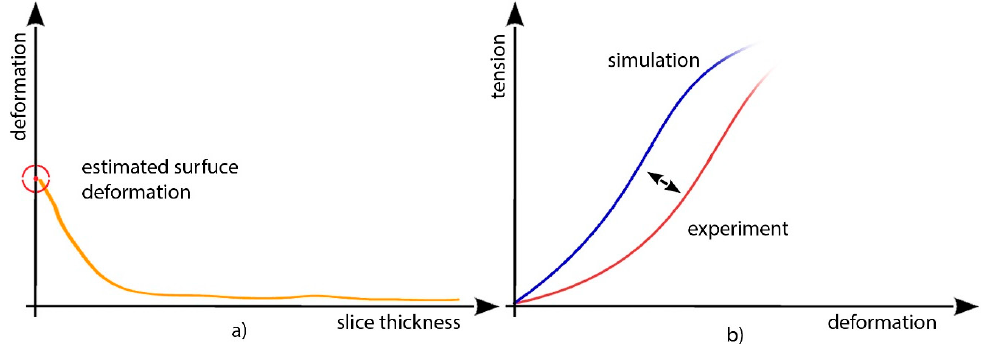
Figure 15. ( a ) Data interpolation of deformation over slice thickness to estimated surface force penetration and ( b ) data comparison of measured shear forces with computational model behavior to validate the the procedure. For any slice thickness, 10 obtained values are required to obtain reliable measure of deformation using semi ‐ ex ‐ post analysis and with maximal semi ‐ dispersion for the field of uncertainty.